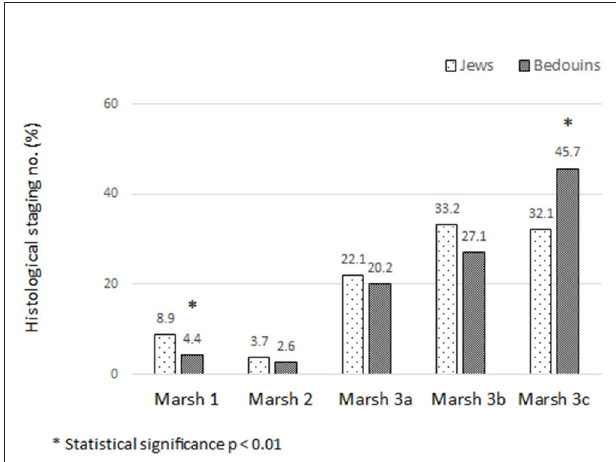
FIGURE 1 | Histological severity among the 2 groups.